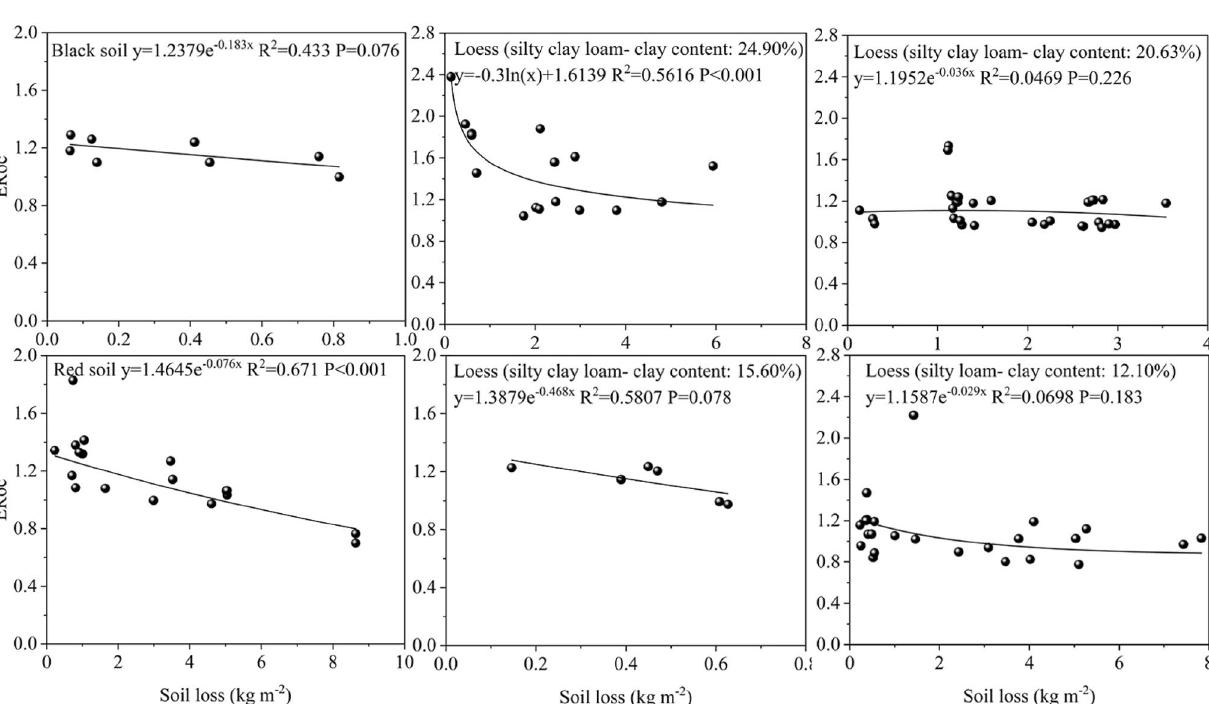
Δ ERoc is the change in ERoc when the rainfall intensity increases by 50 mm h −1 ; Δ ERoc RI increases by